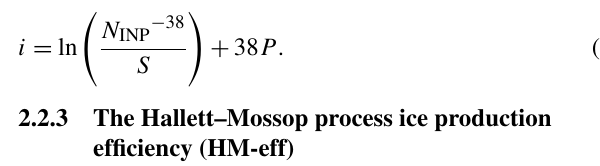
Table 2. Experiment design. The base case, minimum, and maximum values of the variables perturbed in this study. Uncertain parameter Base case Minimum value of λ INP ( ◦ C − 1 ) [value of P in Eq.